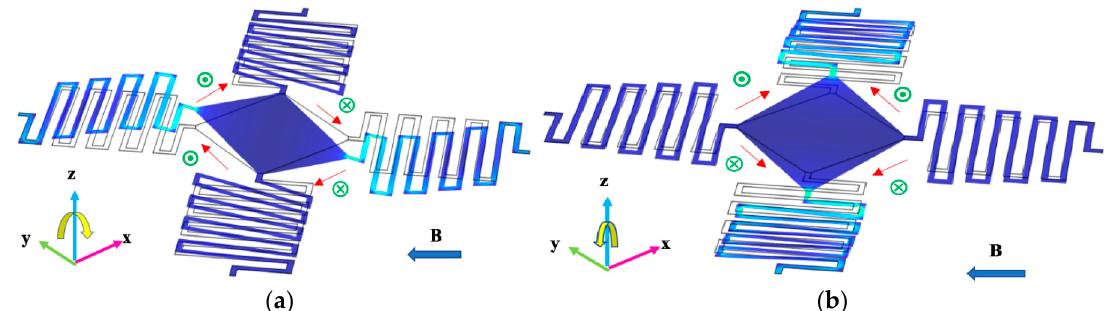
Figure 1. Schematic of the MEMS mirror, blue arrow shows the direction of magnetic field B, red arrows show the directions of current, green circles show the directions of force. ( a ) The φ tilt mode. ( b ) The θ tilt mode.